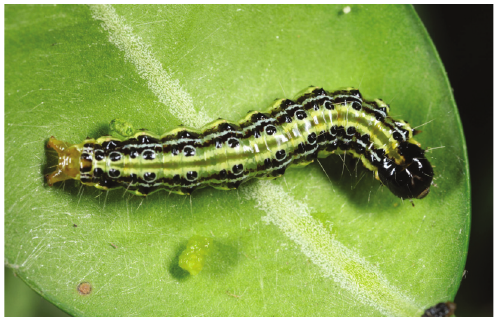
FIGURE 2. Newly hatched larvae, excrement and webbing of box tree moth ( Cydalima perspectali ) (26 September 2013)